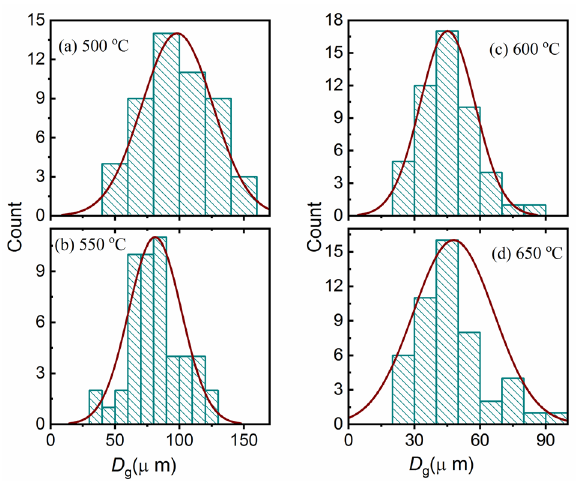
Figure 7. ( a – d ): Histograms for the grain size ( D g ) distribution of In 2 S 3 thin films at different annealing temperatures.